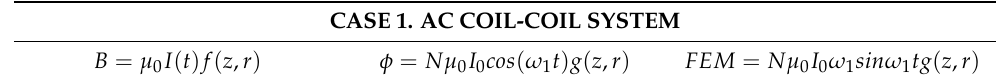
Table 1. Summary table of equations, case